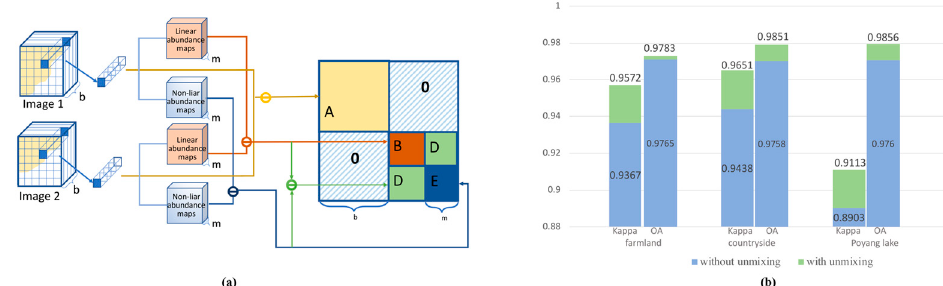
Figure 20. Representative examples of pixel-based methods for correlation analysis. (a) Consider the relationship between adjacent pixels on the same image (layer). (b) Consider the relationship between the corresponding pixels of different images. (c) Consider the relationship between pixels on different layers of the same image.